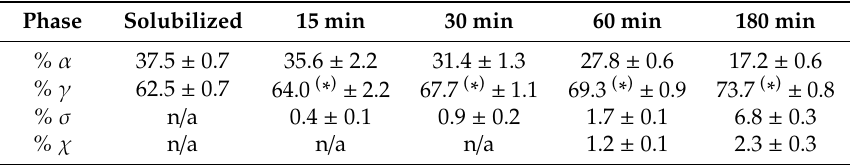
Table 1. Normalized area fraction of phases measured by EBSD.